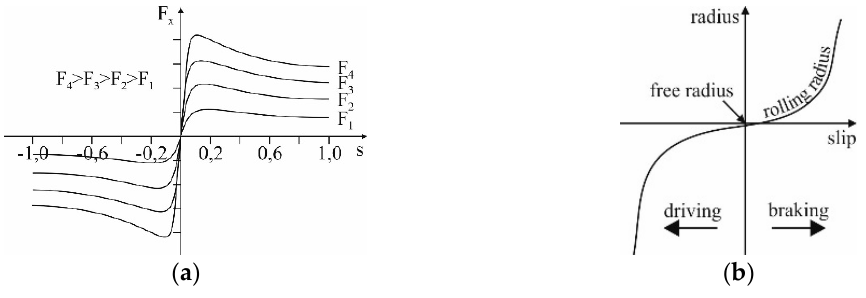
Figure 3. Changes in wheel radius ( a ) as a function of static load; ( b ) during motion, under the driving force/braking force.